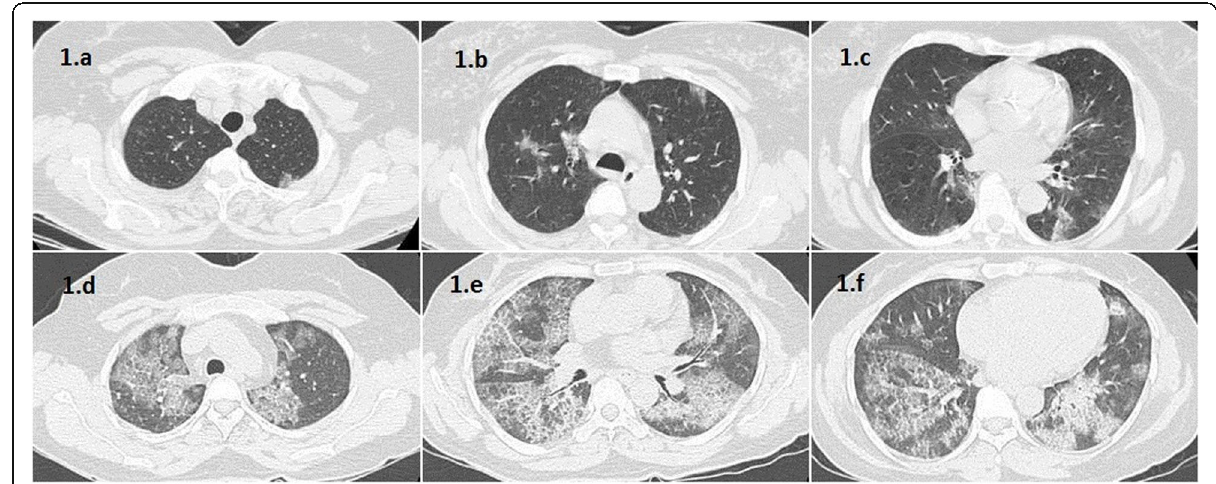
Fig. 1 a - c 45-year-old female with clinically mild COVID and SQS of 8, d - f 52-year-old male with clinically severe COVID and SQS of